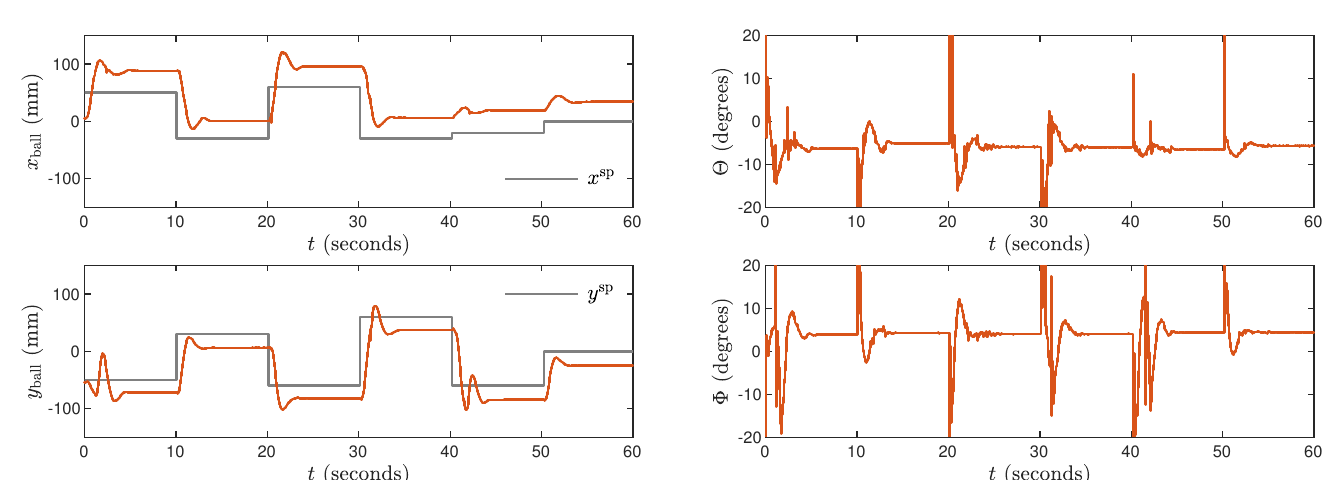
Figure 8. Experimental results of the PD